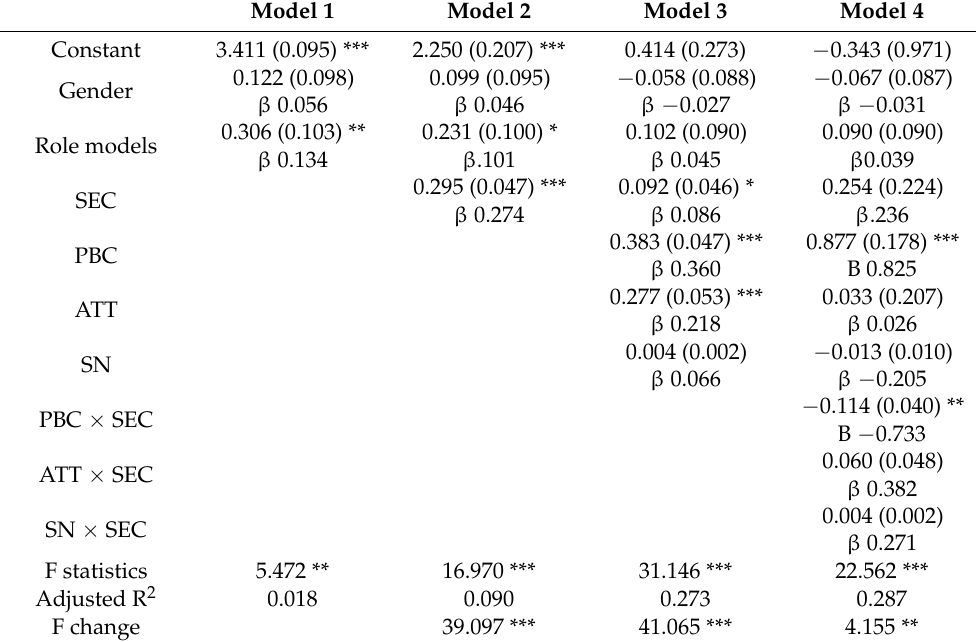
Table 3. Results for higher education students.